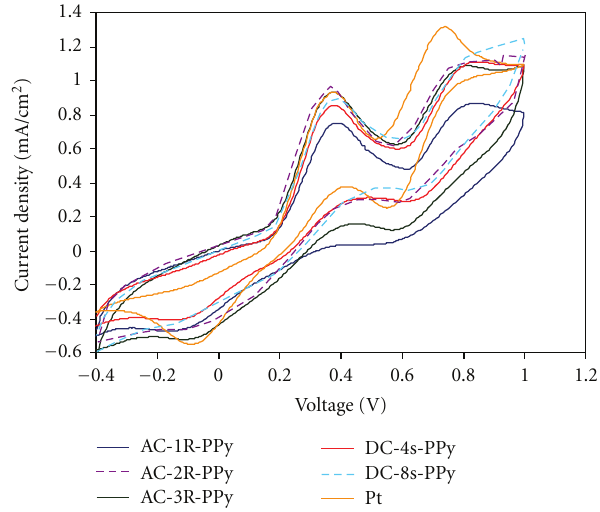
Figure 4: Cyclic voltammogram (CV) curves of PPy and Pt films at a scan rate of 20 mV/s in 10 mM LiI, 1 mM I 2 , and 0.1 M LiClO 4 in acetonitrile solution.